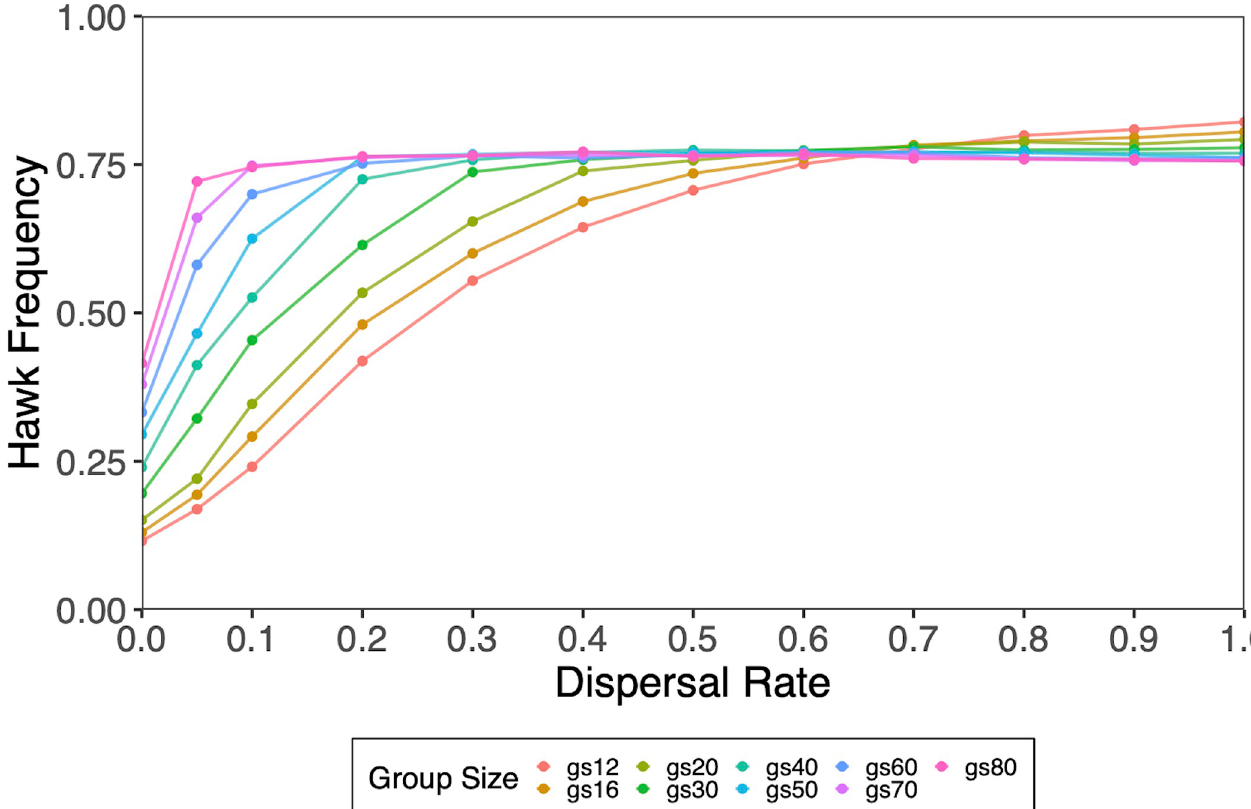
Fig 4. Natal dispersal for different values of GS max with b / c = 0.75. Dispersal rates of d = 0 to 1.0 were tested. As natal dispersal increases group breaks down; allowing the exploitation of doves by hawks.